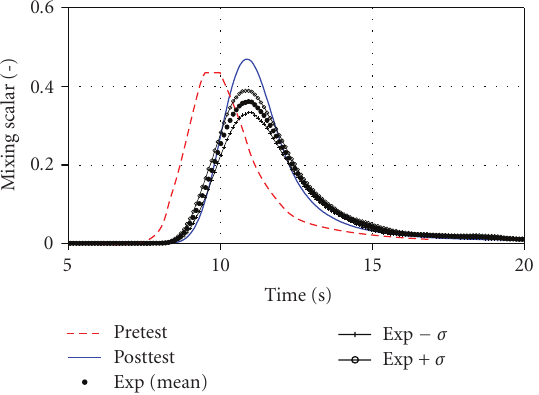
Figure 9: Core-averaged mixing scalar.